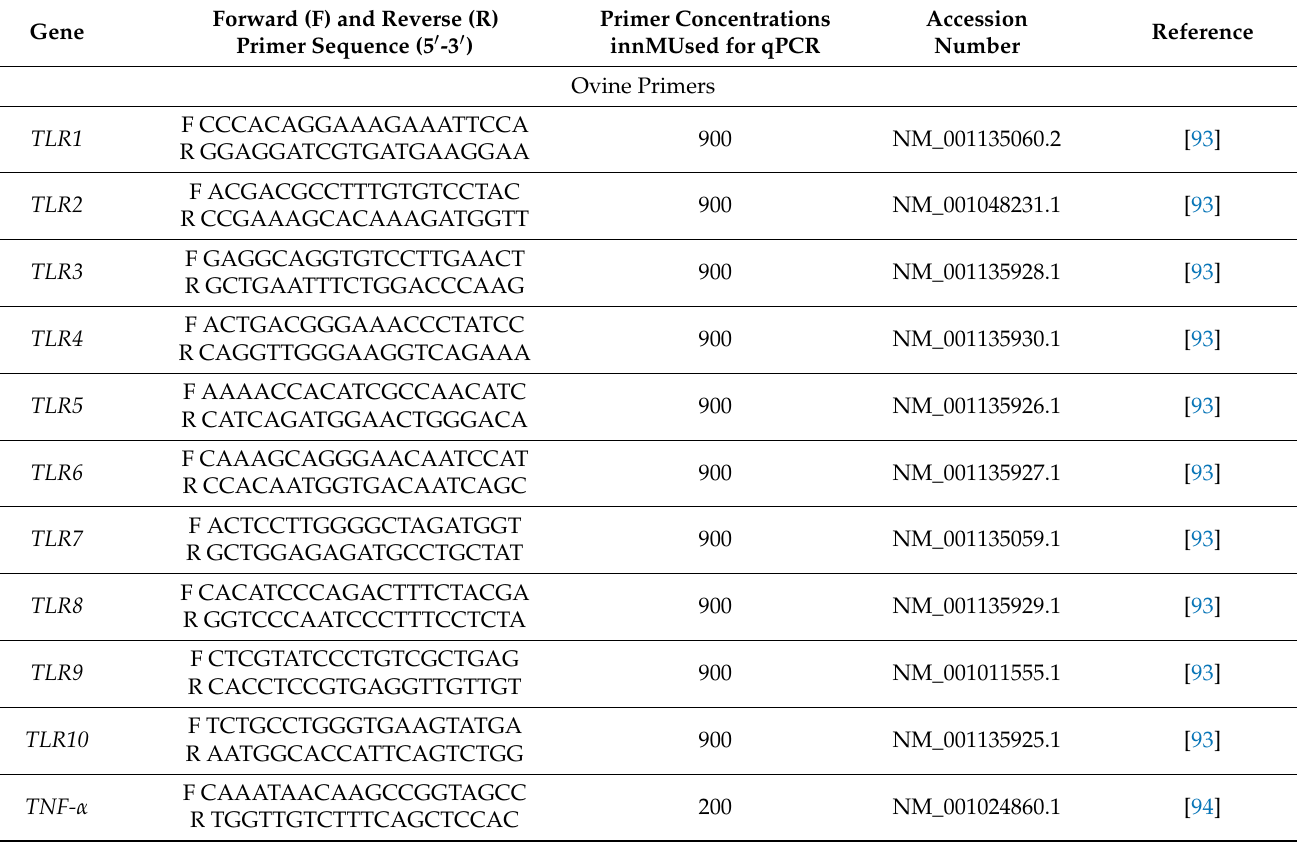
Table 2. Primers used for quantification of gene expressions